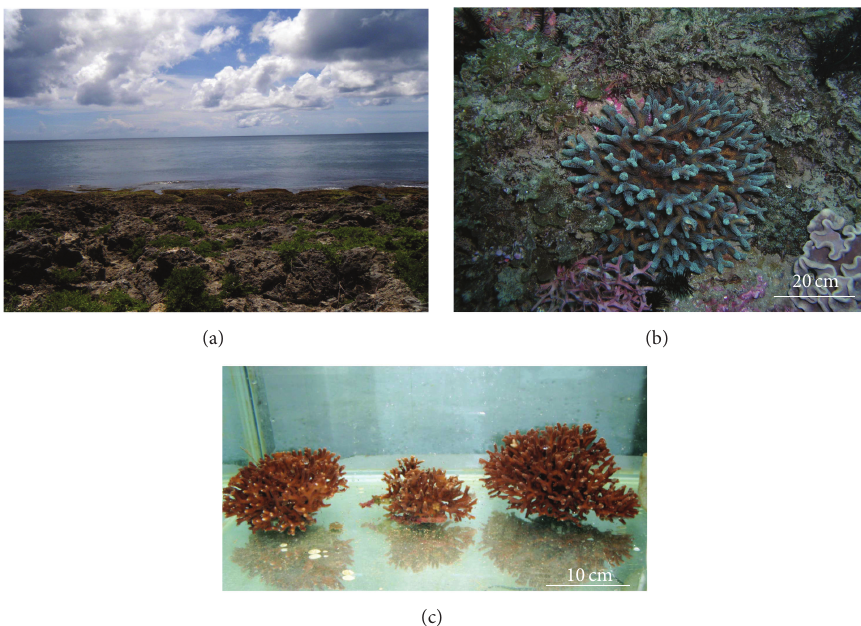
Figure 1: Field site and model coral. Corals were collected from two field sites in southern Taiwan, Houbihu (see Figure 1 of [4]) and Houwan (a). Seriatopora hystrix colonies (b) were collected in situ and transported to aquaria (50 l; c) at Taiwan’s National Museum of Marine Biology and Aquarium (NMMBA). Ten “nubbins” of approximately 2g were generated from each of 12 such colonies (6 from Houbihu and 6 from Houwan) for use in the experiment [4].